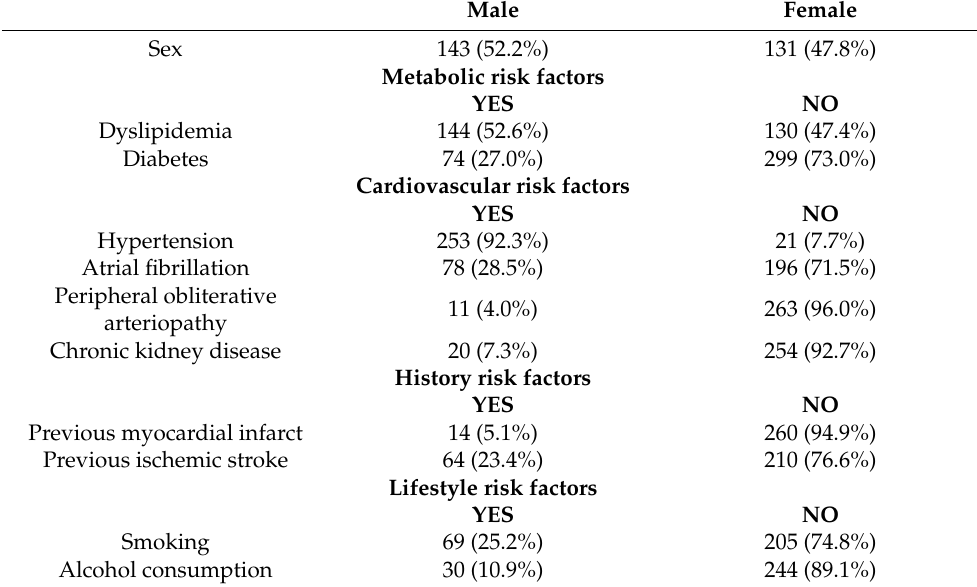
Table 2. Frequency table.